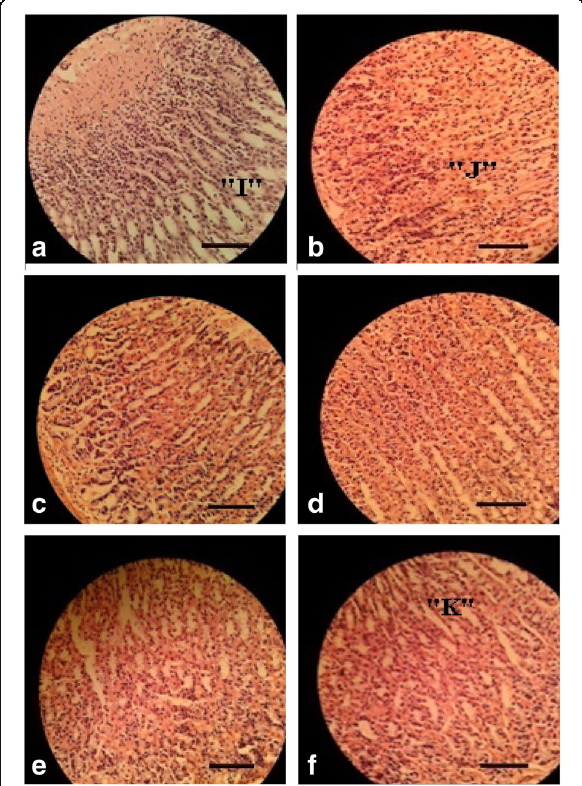
Fig. 4 Histological evaluation of anti-ulcer effect of methanolic extract of P. niruri. a Normal control, b Ethanol control, c 20 mg/kg omeprazole, d 100 mg/kg methanolic extract of P. Niruri , e 200 mg/kg methanolic extract of P. Niruri , f 400 mg/kg methanolic extract of P. Niruri . Each group was assessed at 400× magnification, scale bar: 20 μ m; “ I ” indicates normal gastric mucosa, “ J ” indicates degeneration of gastric mucosa and infiltration of inflammatory cells frequently observed in the specimen from the stomach, “ K ” indicates almost complete regeneration of gastric